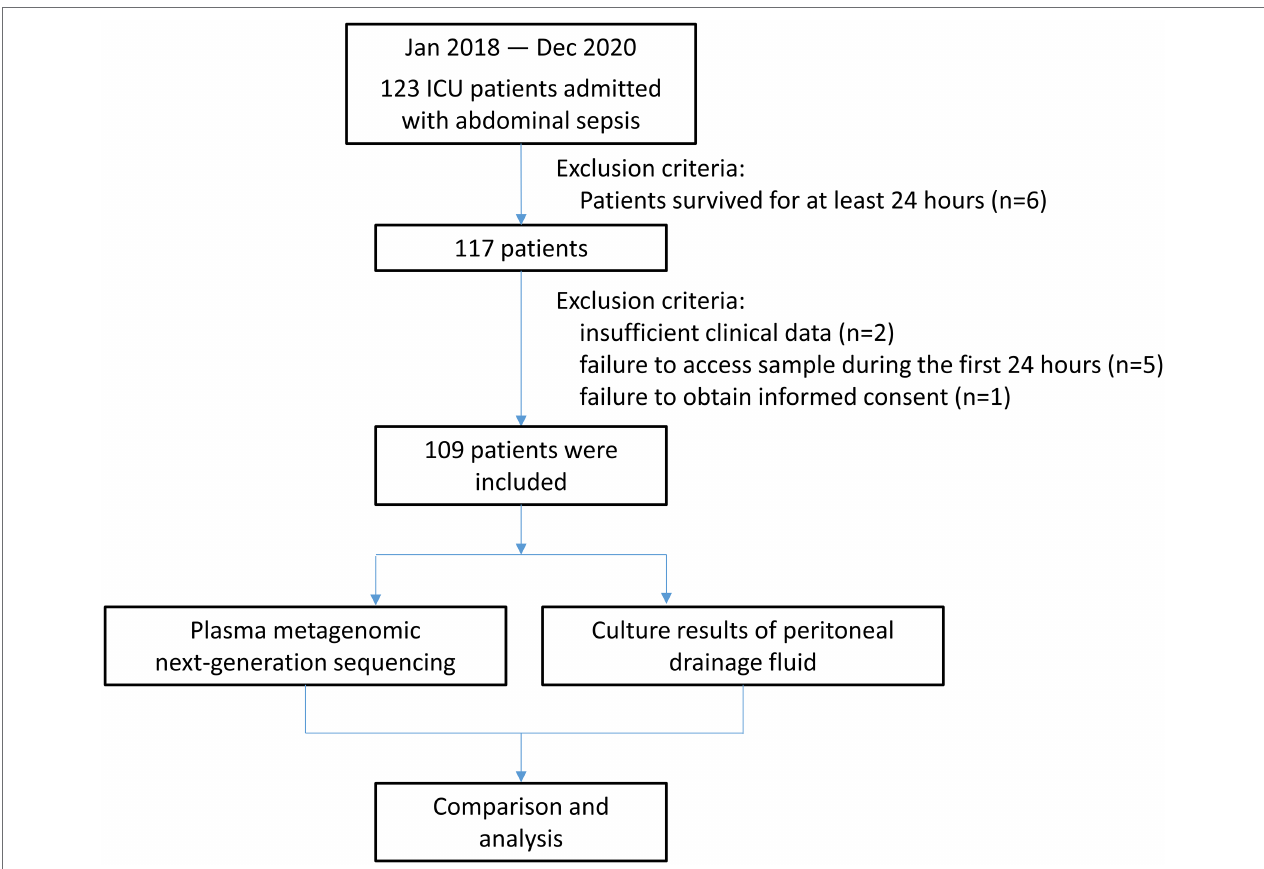
FIGURE 1 | Flowchart of the prospective